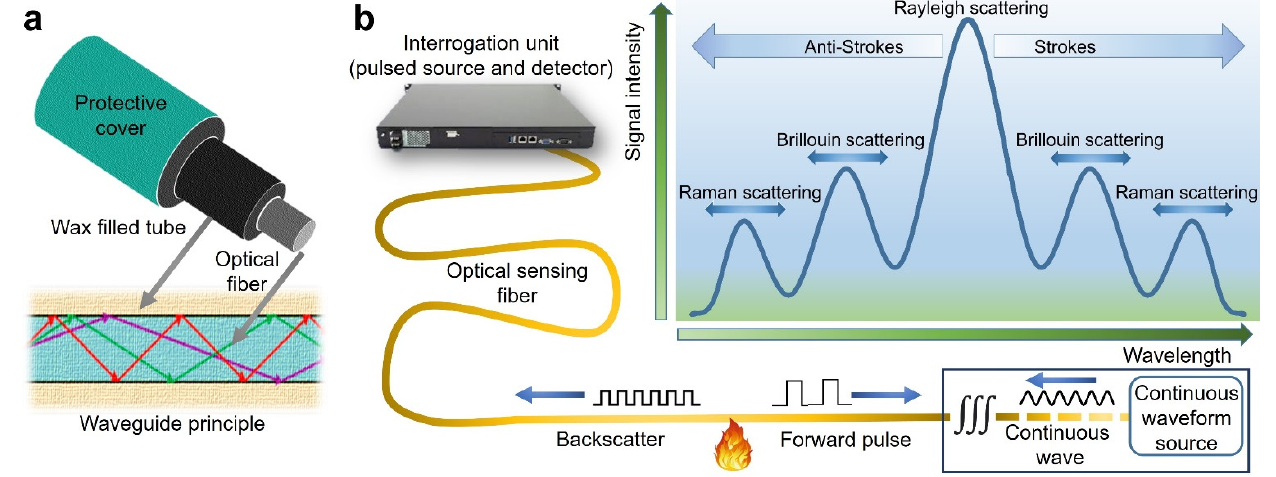
Figure 4. Optical fiber: ( a ) typical cross-section and waveguide principle; ( b ) basic scheme of fire sensing setup and different scattering components in optical glass fibers.